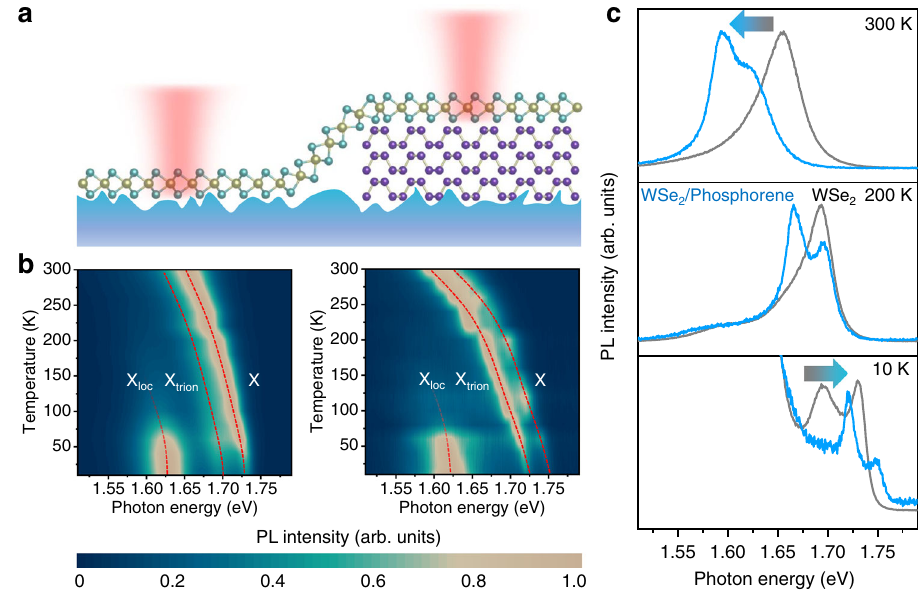
Fig. 3 Temperature-dependent PL characterizations. a Schematic diagram of PL characterizations on WSe 2 /SiO 2 and WSe 2 /phosphorene/SiO 2 regions. b PL of neutral exciton (X), charged exciton (X trion ) and localized exciton (X loc ) in isolated WSe 2 on SiO 2 substrate and WSe 2 /phosphorene heterostructure from 10 to 300 K. The red dashed lines serve as guide lines. c The normalized PL spectra of isolated WSe 2 (gray lines) and WSe 2 / phosphorene heterostructure (blue lines) at 10, 200, and 300 K. Here, the gray-blue arrows indicate that the photon energy of X and X trion in WSe 2 / phosphorene/SiO 2 heterostructure is blue-shifted/red-shifted relative to those in WSe 2 /SiO 2